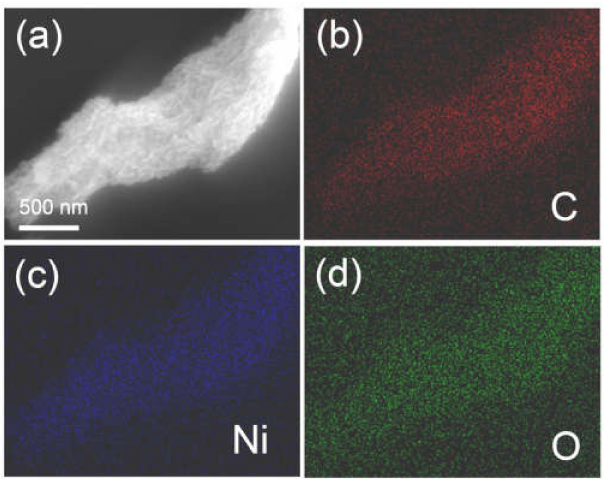
Figure 4. SEM image ( a ) of NiO / CMK-3 composite and the corresponding elemental mapping images of carbon ( b ), nickel ( c ), and oxygen ( d ).